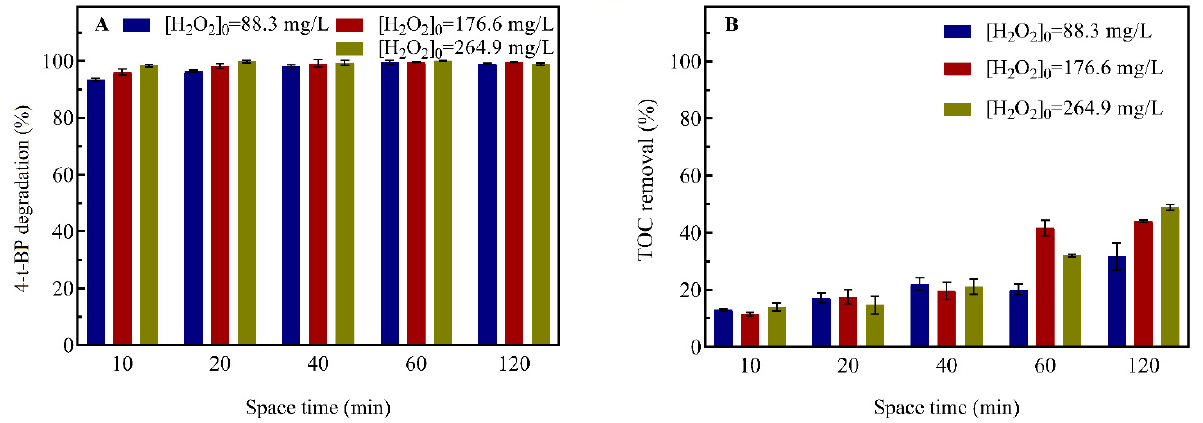
Figure 3. 4-t-BP degradation ( A ) and TOC removal ( B ) as a function of space time in the UV/H 2 O 2